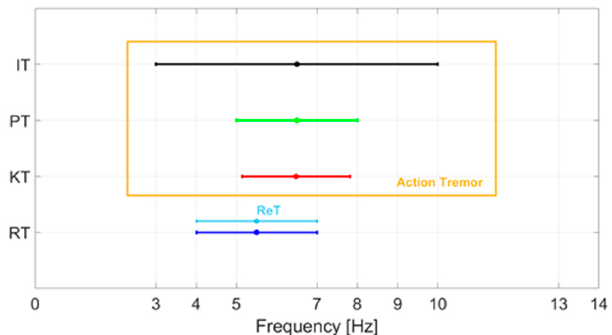
Figure 1. Characteristic frequencies of the various tremors of PD: rest tremor (RT), kinetic tremor (KT), postural tremor (PT), intentional tremor (IT), re-emerging tremor (ReT).